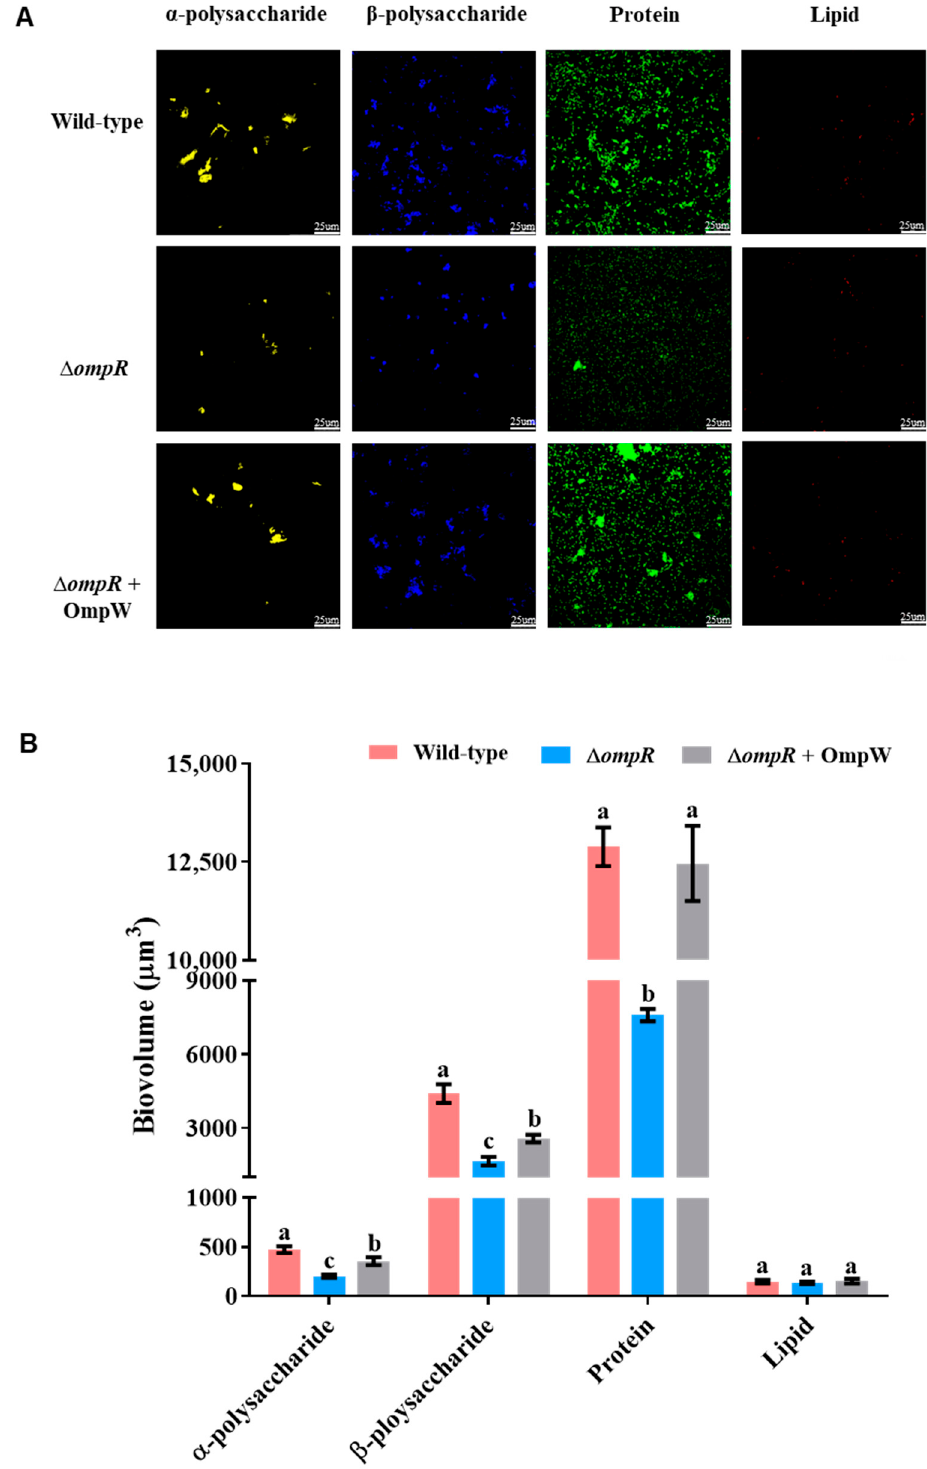
Figure 5. The effect of ompR gene deletion on the content of EPS in biofilms. ( A ) The CLSM images of EPS in wild-type biofilms, Δ ompR biofilms, and biofilms formed by Δ ompR co-cultured with 10 mg L − 1 recombinant OmpW protein; and ( B ) biovolume analysis of EPS in biofilms. Different letters indicate significant differences ( p < 0.05). The extracellular α -polysaccharide, β -polysaccharide and protein levels of Δ ompR biofilms (with 10 mg L − 1 OmpW) and wild-type biofilms were significantly higher than